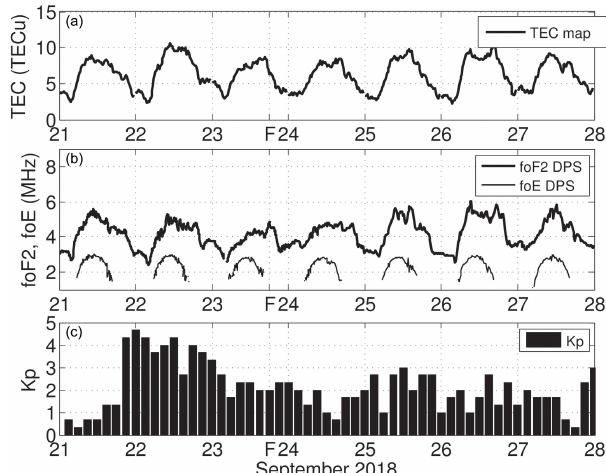
Figure 10. Diurnal courses of total electron content (a) , critical fre- quencies foF2 and foE (b) above station Pruhonice (“F” denotes the time of passage of storm Fabienne over the station) and the course of the Kp index (c) during the observational